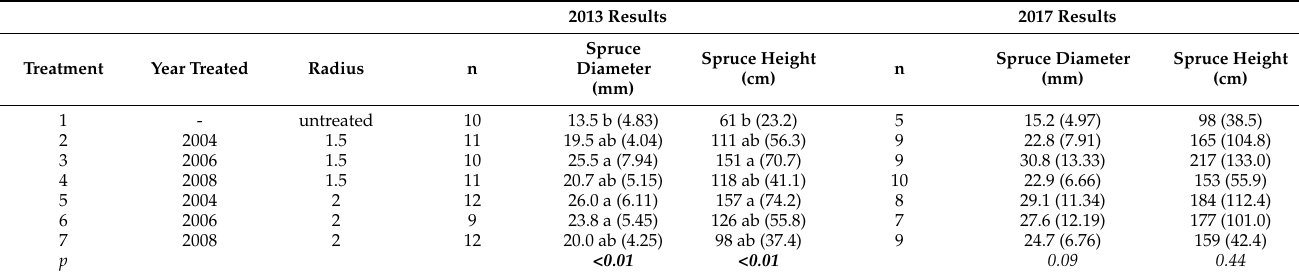
Table 3. Summary of treatment effects on spruce diameter and height at Judy Creek in 2013 and 2017. Letters in each column (where shown) indicate significant differences detected using Scheffe’s Test at α = 0.05. SD shown in brackets. Significant p values ( α = 0.05) are shown in bold. 2013 Results 2017